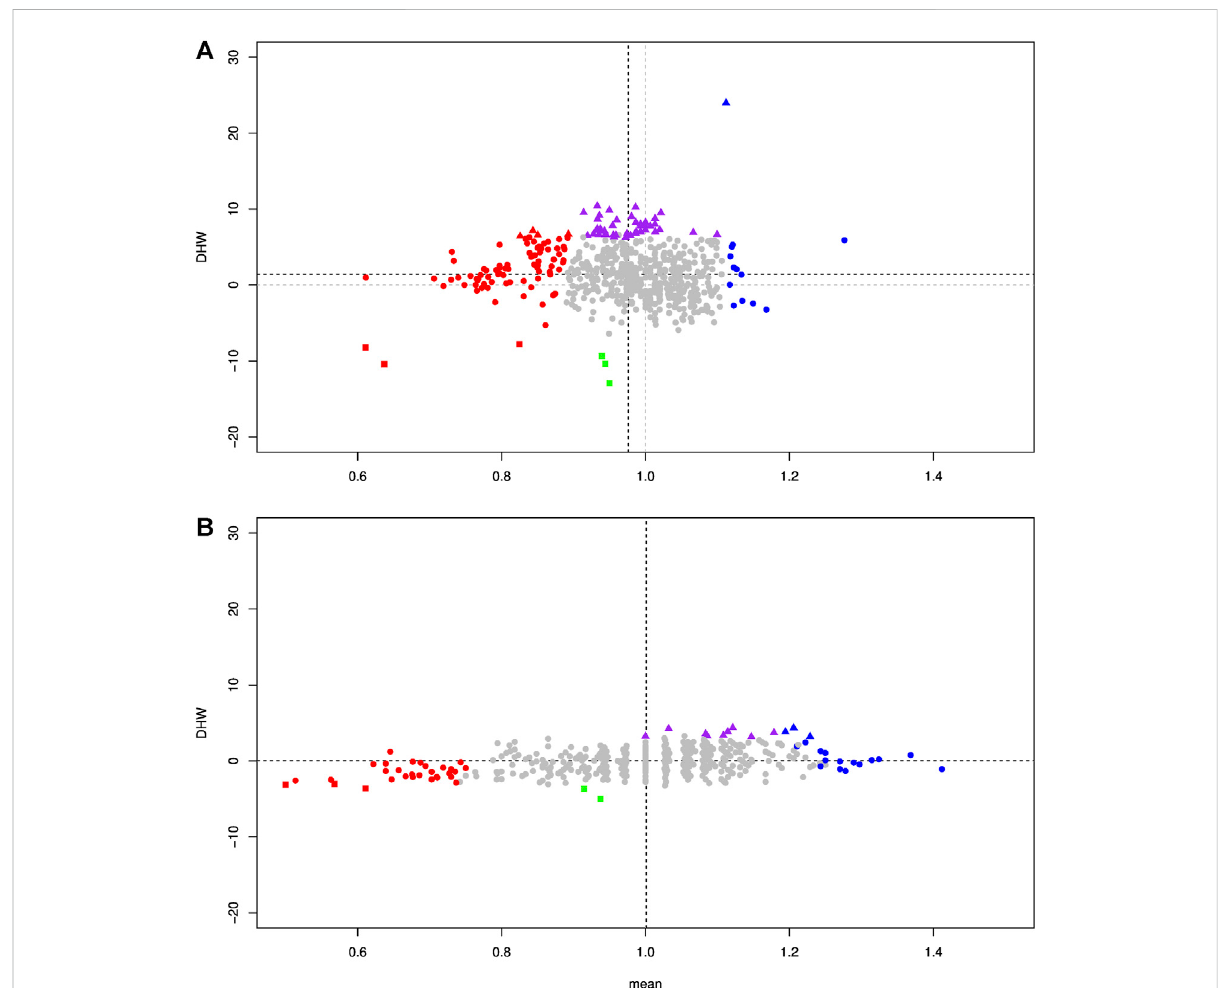
FIGURE 8 Biplot of the DHW statistic of the Hardy – Weinberg deviation as a function of the t-statistic expressing the deviation from 1 for the allelic composition, calculated on F2 individuals. Grey circles represent the SNPs that were not signi fi cant for both tests. Red circles and blue circles representSNPsinHWequilibrium,forwhichallelecompositiondeviatessigni fi cantlyfrom1toward P.toxostoma and T.souf fi a ,respectively.Redand bluetrianglesrepresentSNPsinHardy – Weinbergdisequilibrium(excessheterozygote)forwhichalleliccompositiondeviatessigni fi cantlyfrom 1 toward P. toxostoma and T. souf fi a , respectively. Purple triangles represent SNPs in Hardy – Weinberg disequilibrium (excess heterozygote) whose allele composition does not deviate signi fi cantly from 1. Red squares represent SNPs in Hardy – Weinberg disequilibrium (excess P. toxostoma homozygote) whose allelic composition deviates signi fi cantly from 1 toward P. toxostoma . Green squares represent SNPs in Hardy – Weinberg disequilibrium (excess homozygote for both species) for which allelic composition does not deviate signi fi cantly from 1. (A) Specimens with a size > 2 cm. (B) Specimens with a size of 2